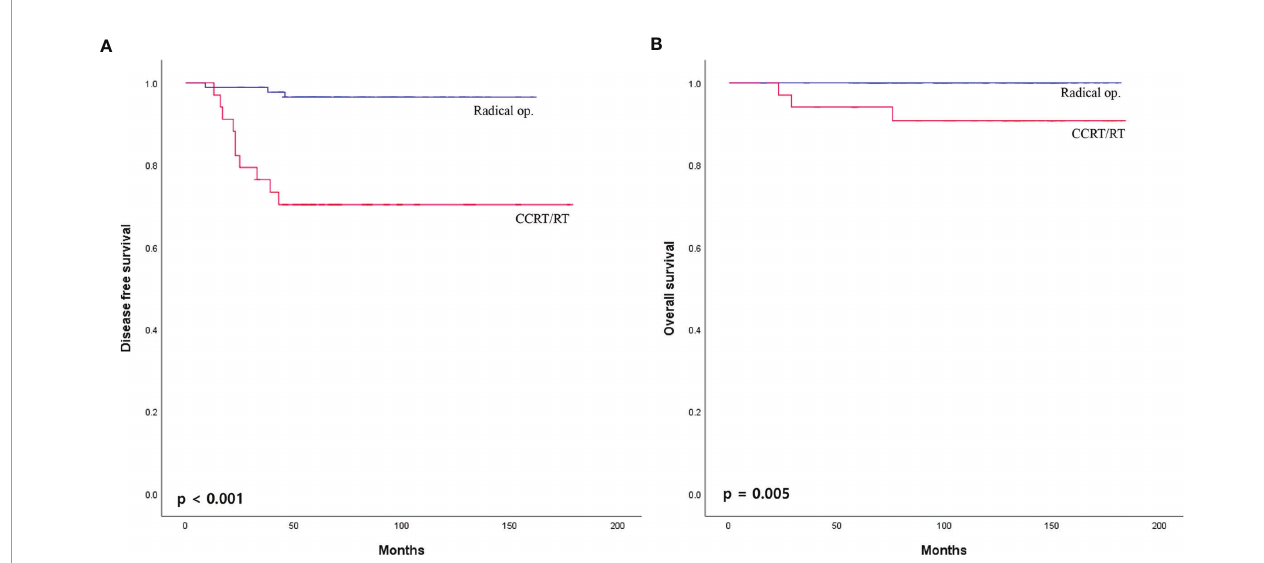
FIGURE 2 | (A) Disease-free survival and (B) overall survival curves of patients with early rectal cancer between CCRT/RT and radical operation